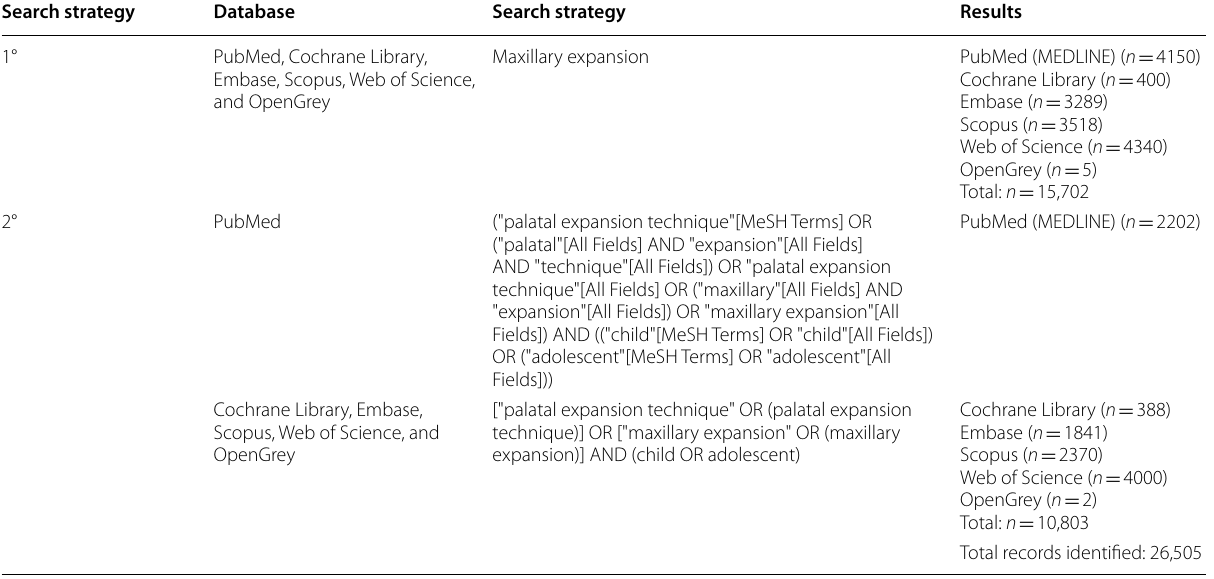
Table 2 Search strategy for electronic